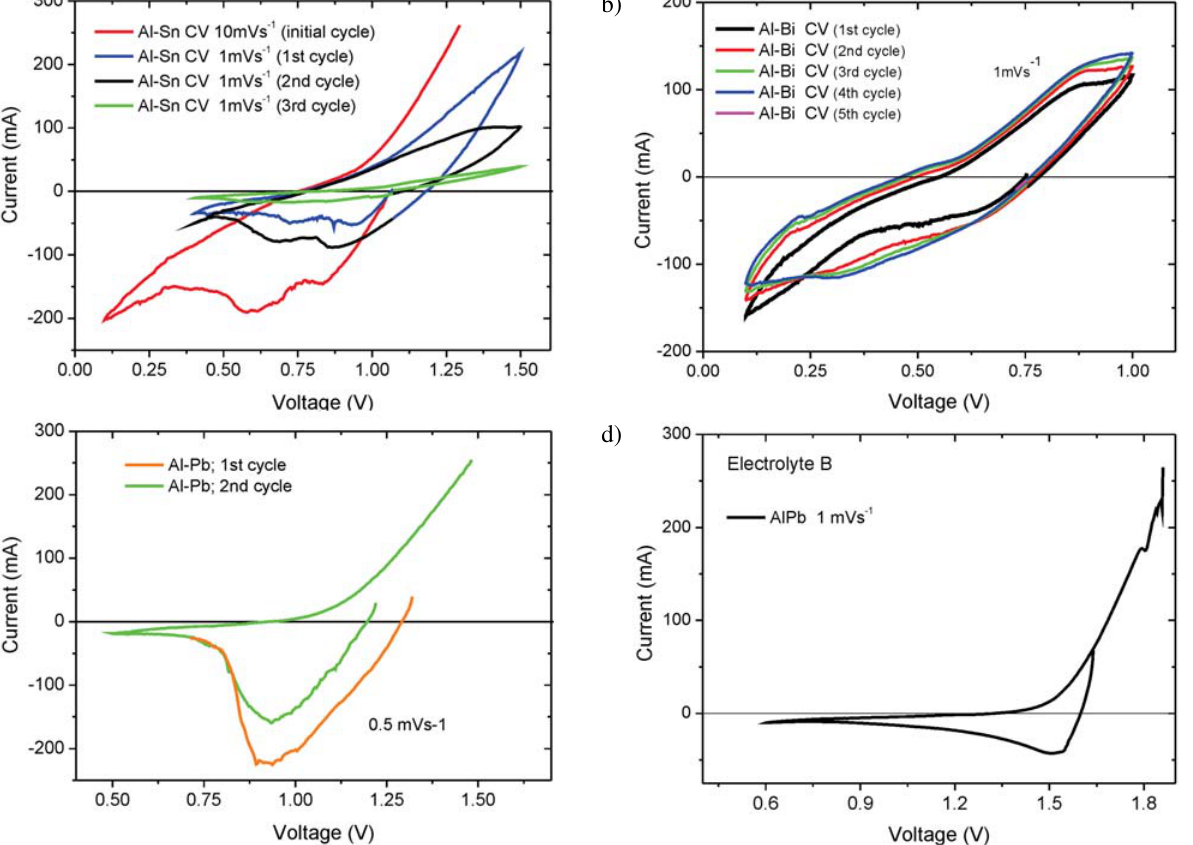
Figure 3. Cyclic voltammograms of different liquid battery cells in electrolyte A: (a) Al-Sn at the rates of 1 mVs –1 (first 3 cycles) and 10 mVs –1 , (b) Al-Bi at the rate of 1 mVs –1 , (c) Al-Pb at the rate of 0.5 mVs –1 (2 cycles). (d) Cyclic voltammograms of a liquid Al-Pb cell with electrolyte